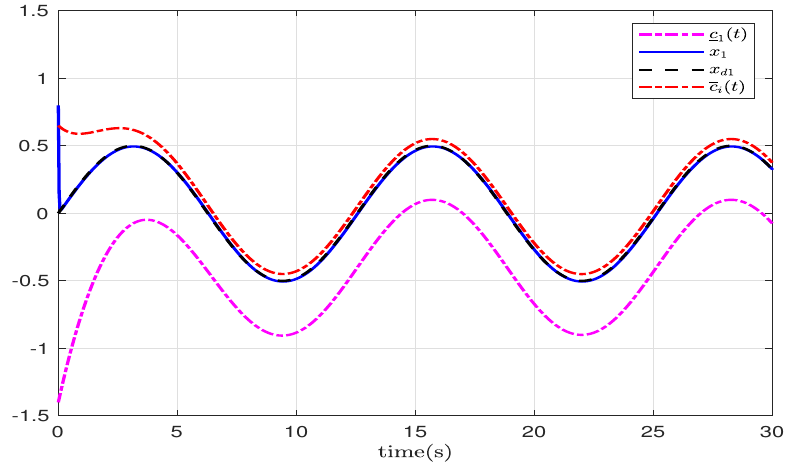
Figure 2. The tracking trajectories of x s and x d 1 .